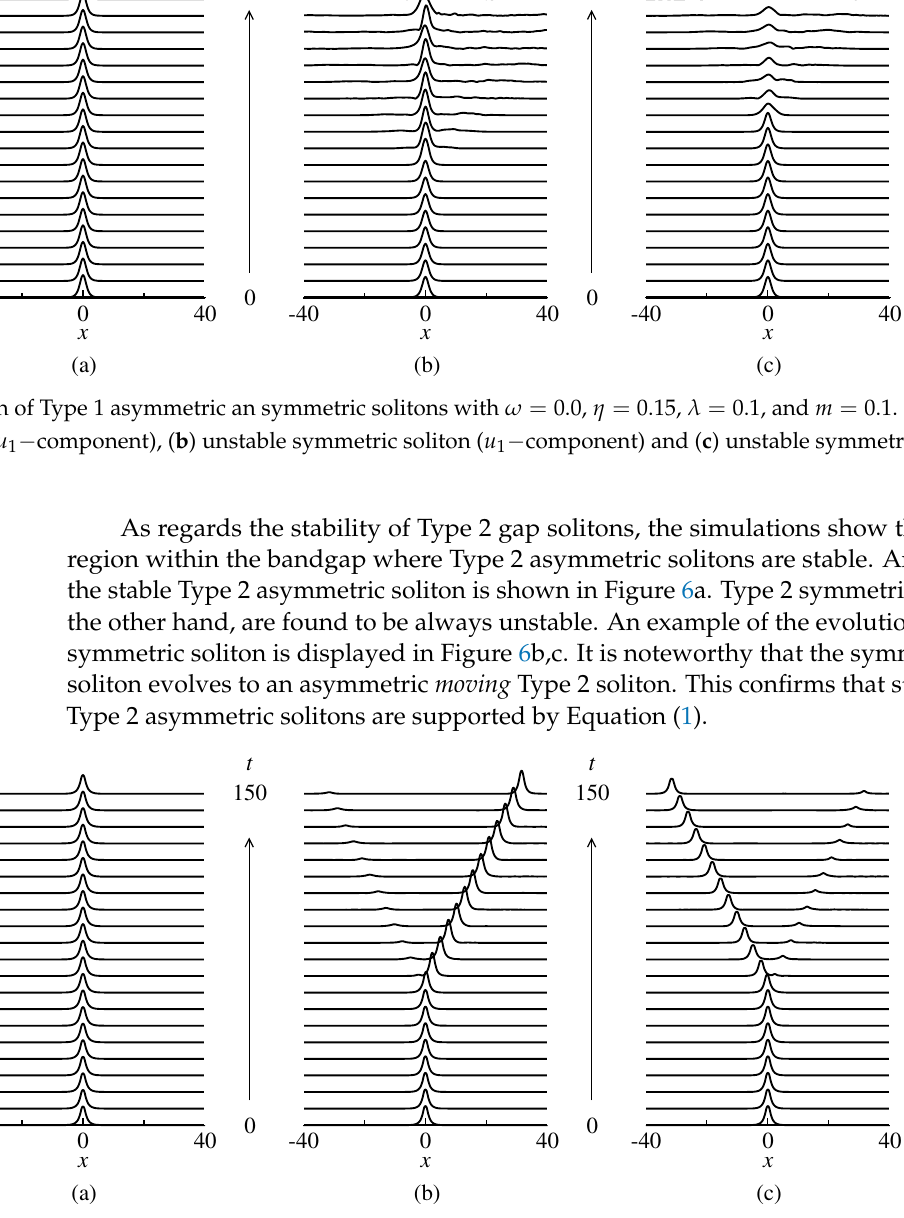
Figure 6. Propagation of Type 2 asymmetric and symmetric solitons with ω = − 0.5, η = 0.9, λ = 0.1, and m = 0.1. ( a ) stable asymmetric Type 2 soliton ( u 1 − component), ( b ) unstable symmetric soliton ( u 1 − component) and ( c ) unstable symmetric soliton ( u 2 −